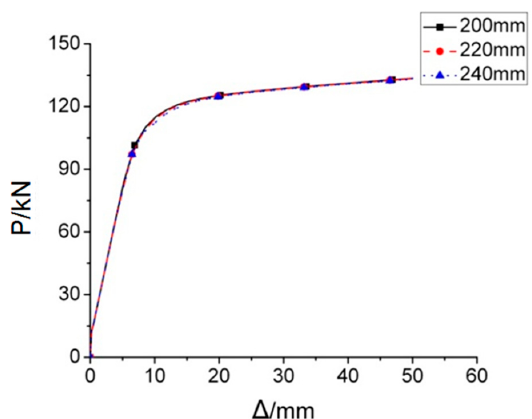
Figure 22. The load-displacement curves of RD series FE models under monotonous loading.